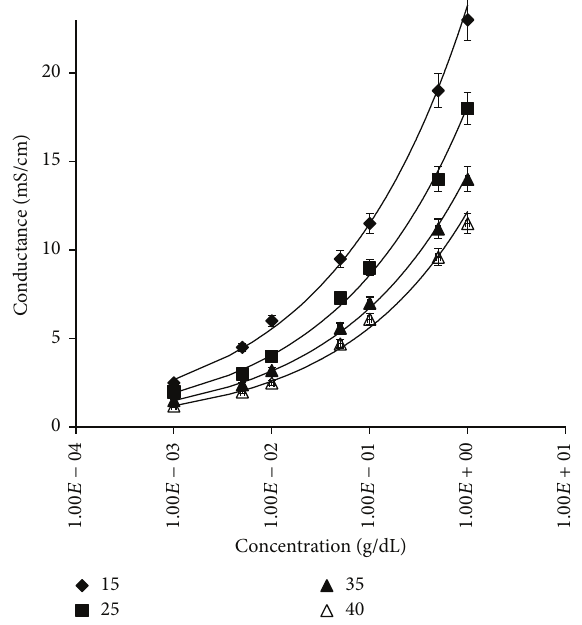
Figure 11: Conductance of polymer sample PS62 as a function of polymer concentration, measured at various temperatures.